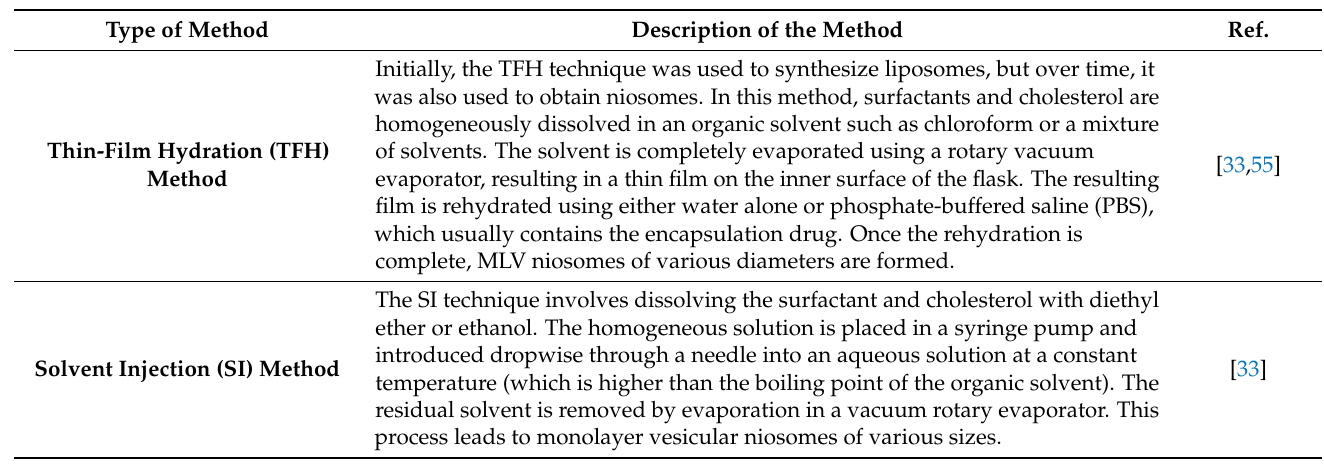
Table 3. Methods for obtaining niosomes.